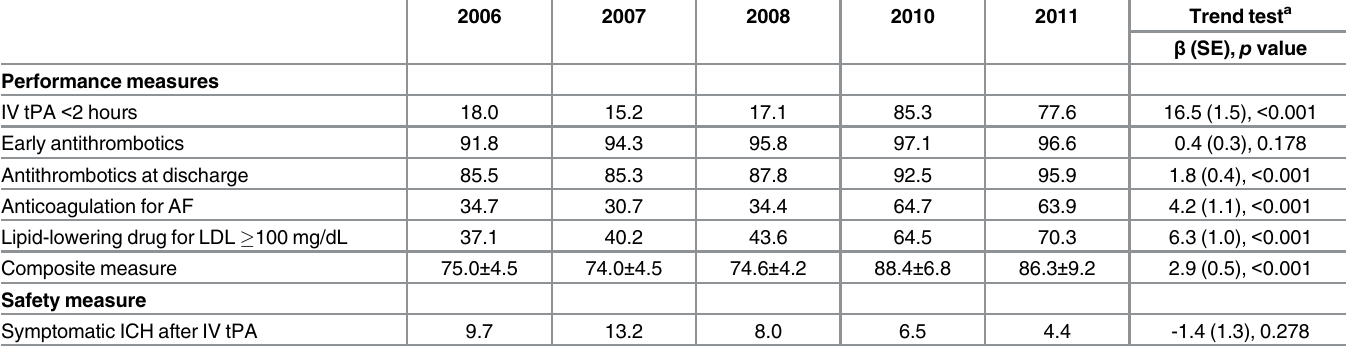
Table 3. Trends of Quality Measures in 14 Hospitals in Group I Before and During BTS-Stroke Activity (2006 –